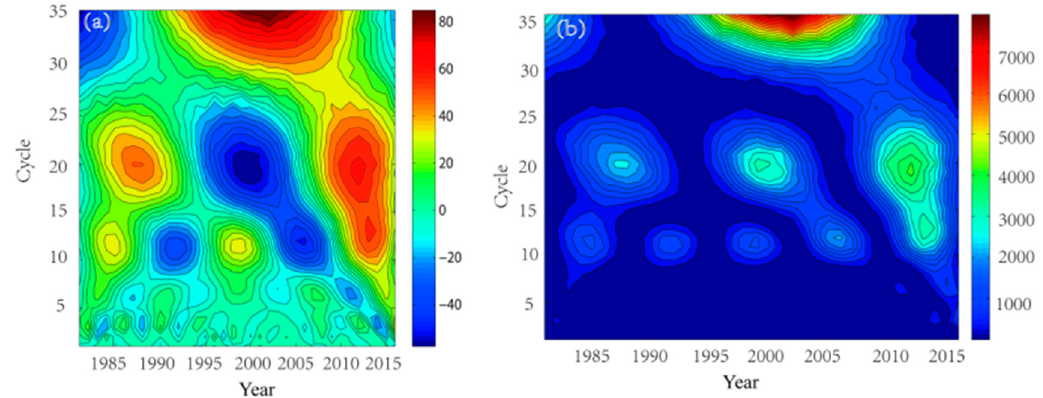
Figure 5. ( a ) The Morlet wavelet transform of extreme precipitation frequency. ( b ) The modular squared time frequency of the Morlet wavelet transformation of the extreme precipitation frequency.